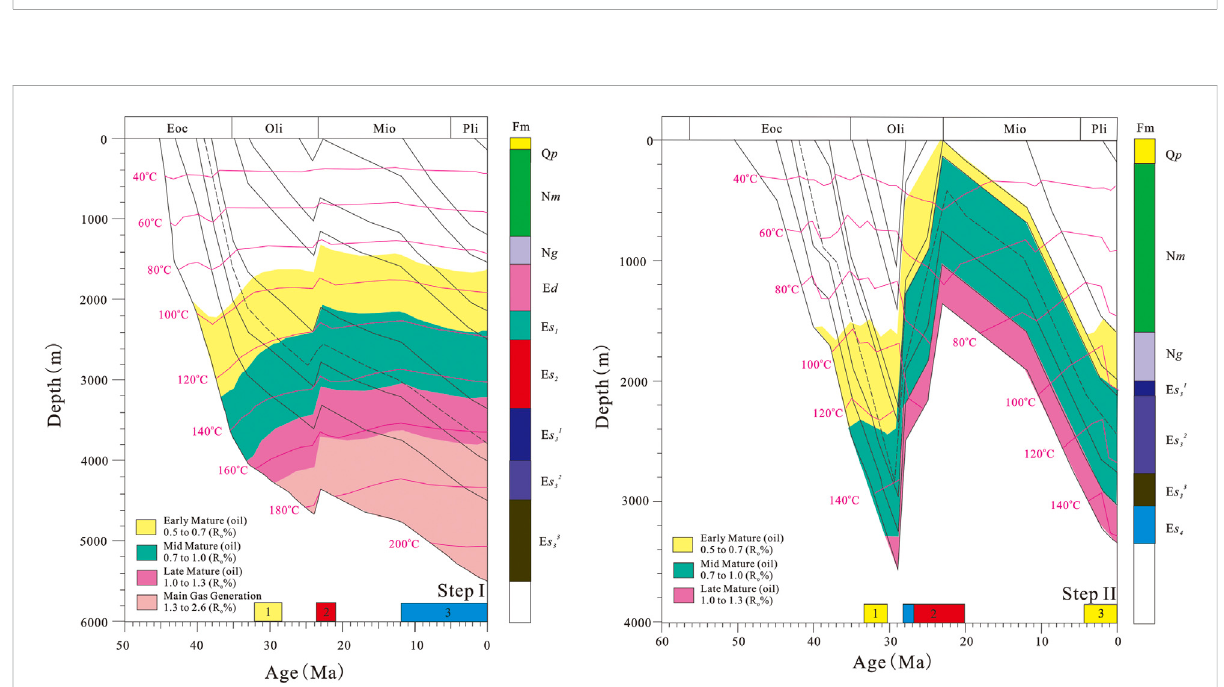
FIGURE 4 Paleocene Formation burial histories of steps I and II, illustrating the CH 4 and CO 2 charging times and multiple-staged oil charging times. The yellow frame represents the trapped period of yellow petroleum inclusions, the red frame represents the trapped period of CH 4 and CO 2 , and the blue frame represents the trapped period of blue petroleum